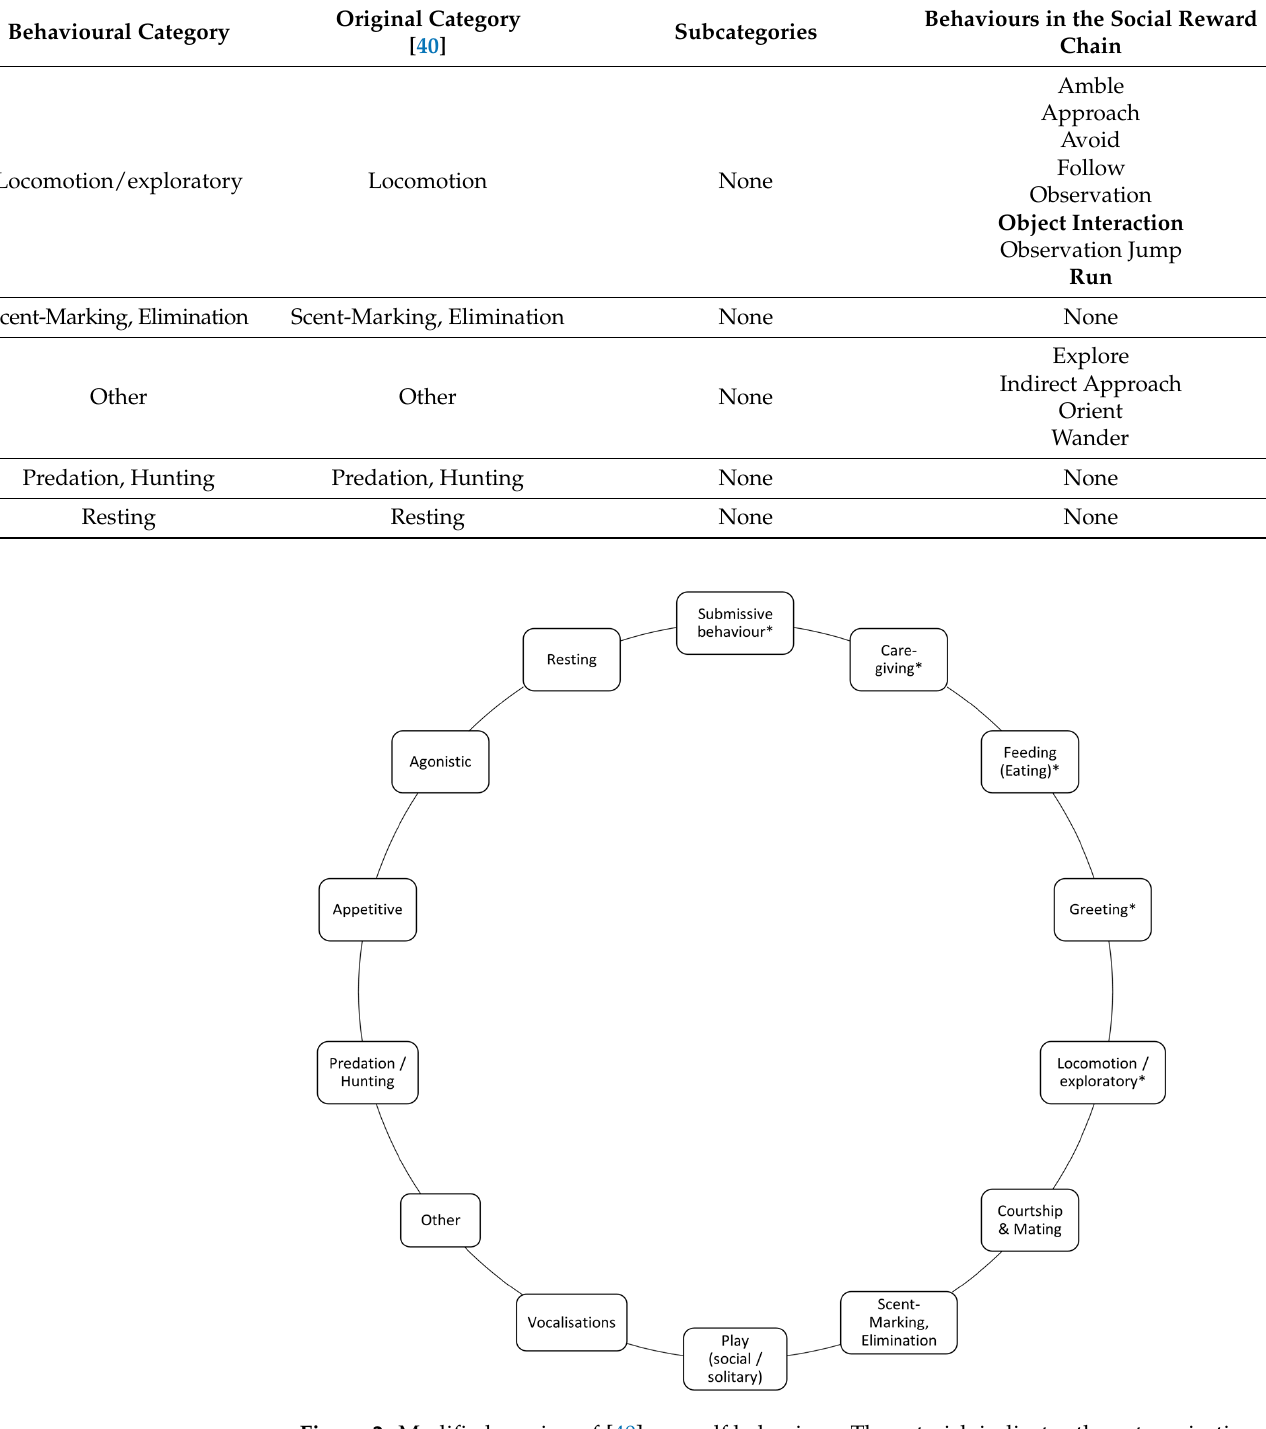
Figure 2. Modified version of [40] on wolf behaviour. The asterisk indicates the categorisation of “behaviours of interest” into behavioural categories.